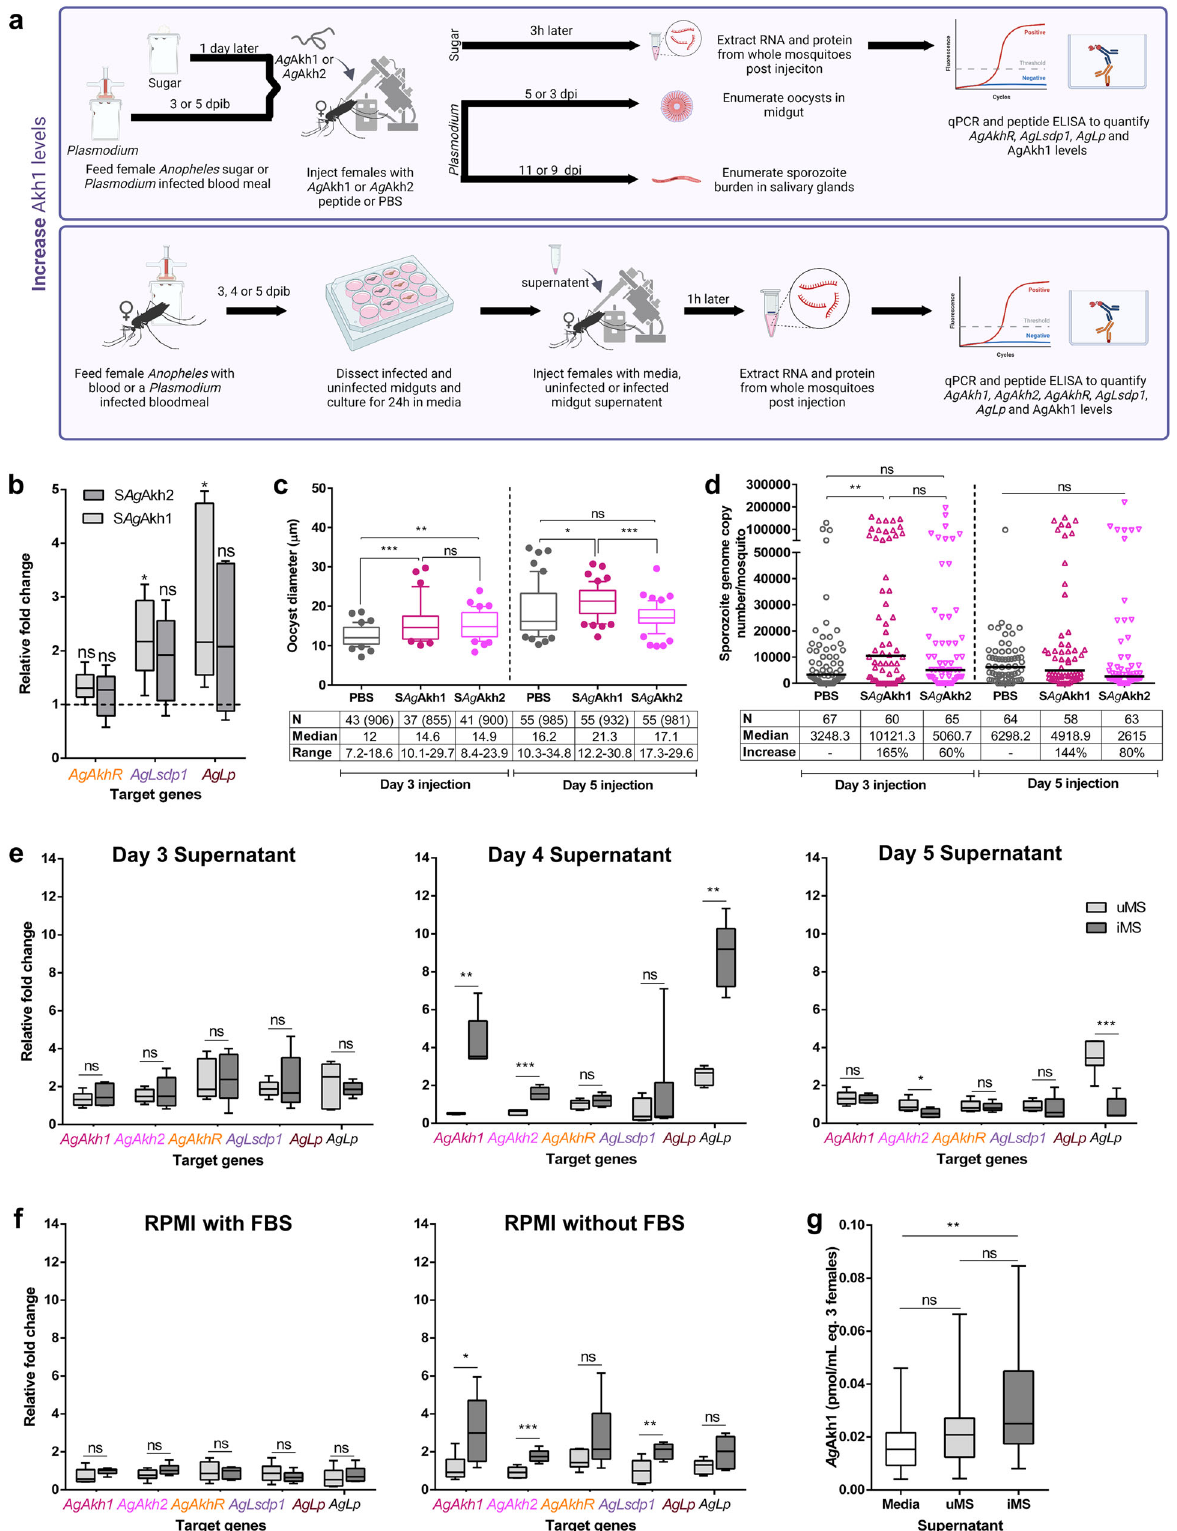
intensity was used to gauge the impact of the synthetic peptides on sporogonic development, while oocyst prevalence and inten- sity were used as a proxy for successful infection. Like the RNAi studies, no signi fi cant difference was detected in 8 dpib oocyst intensity or prevalence when mosquitoes were injected with both peptides at 3 dpib ( χ 2 (2, 106) = 1.906 P =